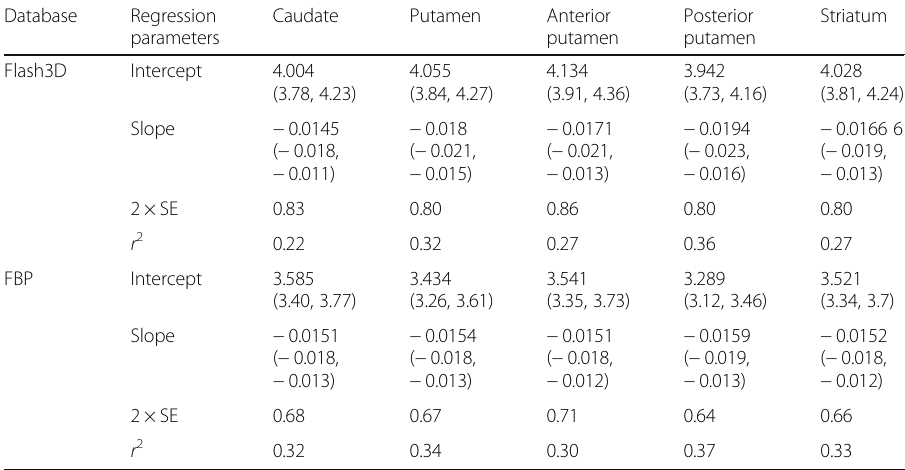
Table 5 Linear regression analysis of DAT availability versus age, irrespective of gender Database